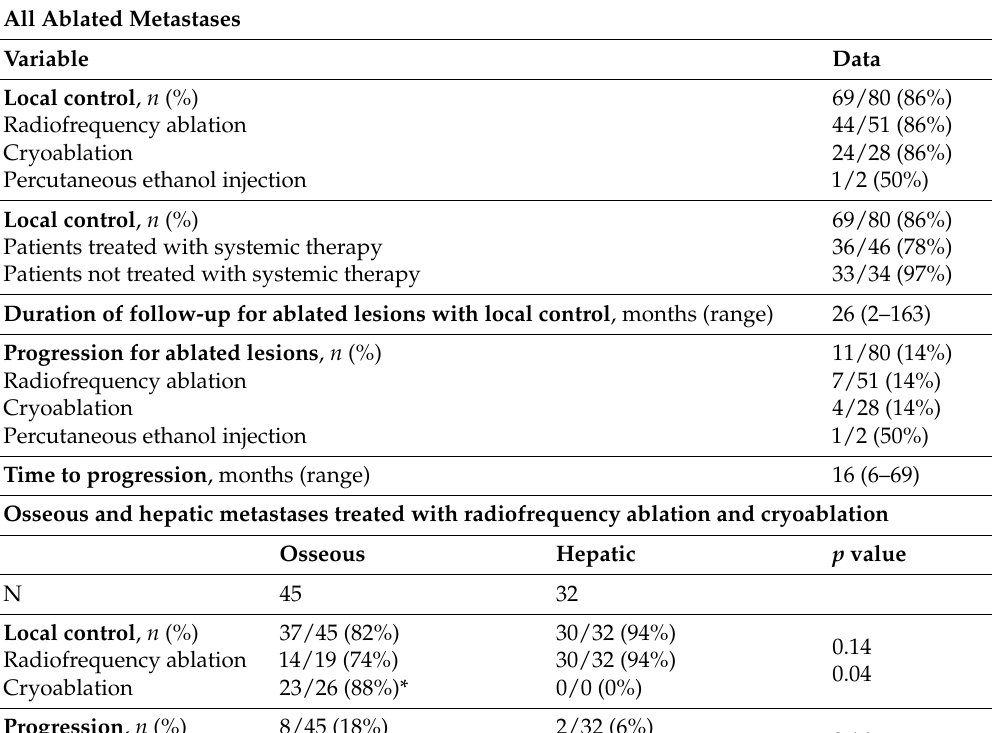
Table 3. Radiographic outcomes of ablated metastases in patients with metastatic pheochromocytoma and paraganglioma. Categorical data presented as absolute and relative frequencies